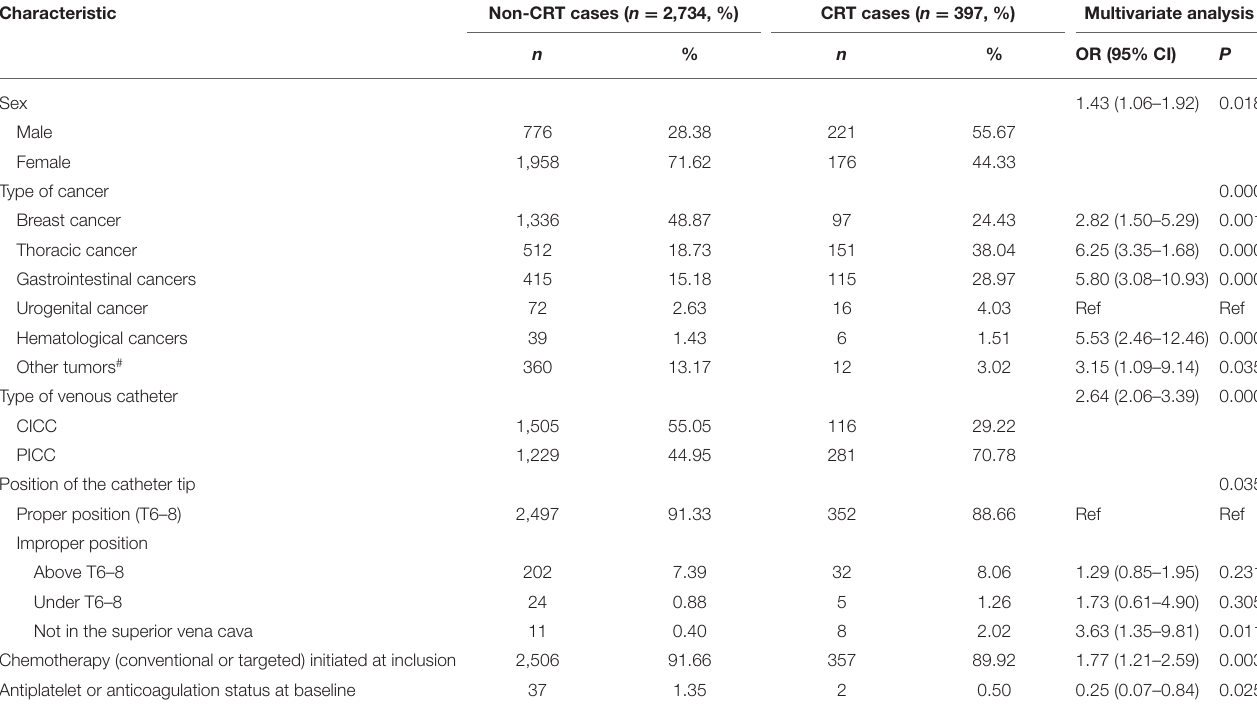
TABLE 3 | Multivariate analysis of the risk of catheter-related thrombosis (CRT). Characteristic Non-CRT cases ( n = 2,734,